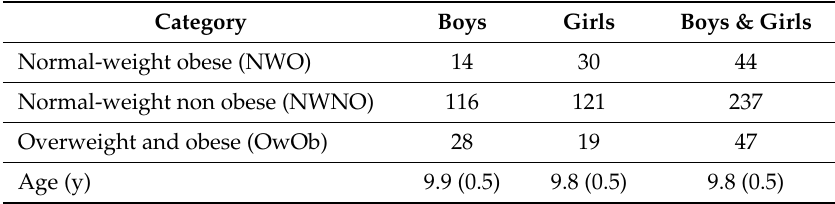
Table 2. Frequency distribution of children from n = 328. Boys Boys &